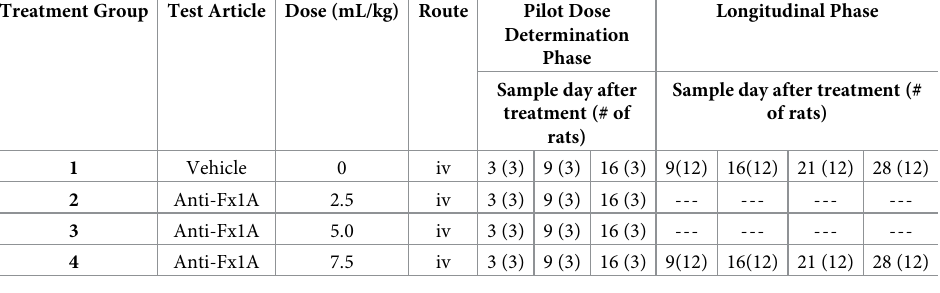
Table 1. Three anti-Fx1A serum doses (2.5 mL/kg, 5.0 mL/kg and 7.5 mL/kg) were evaluated